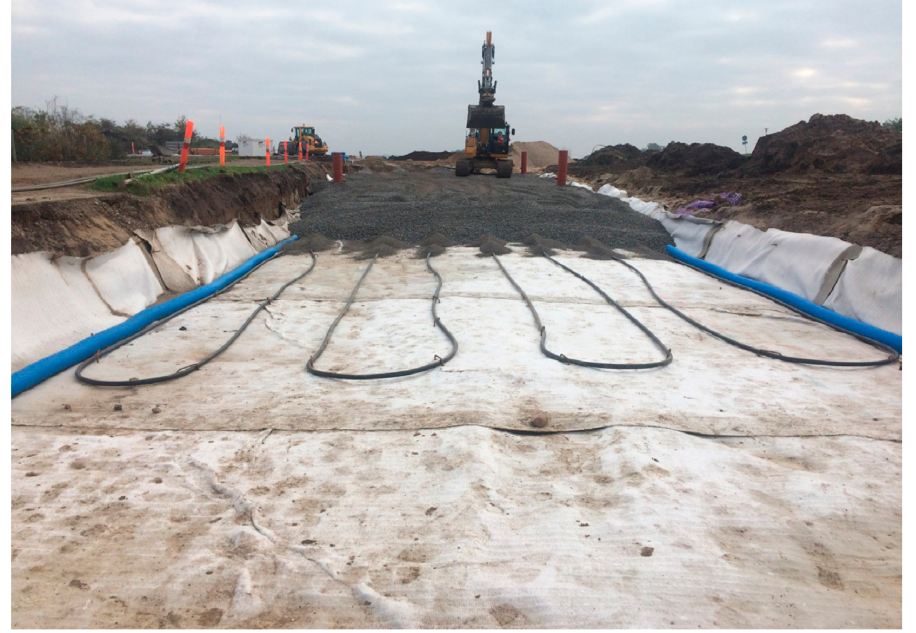
Figure 3. The Climate Road during construction. The Climate Road measures 50 m in length, 8 m in width and 1 m in depth. An im- permeable bentonite membrane lines the sides and bottom of the roadbed (white mem-